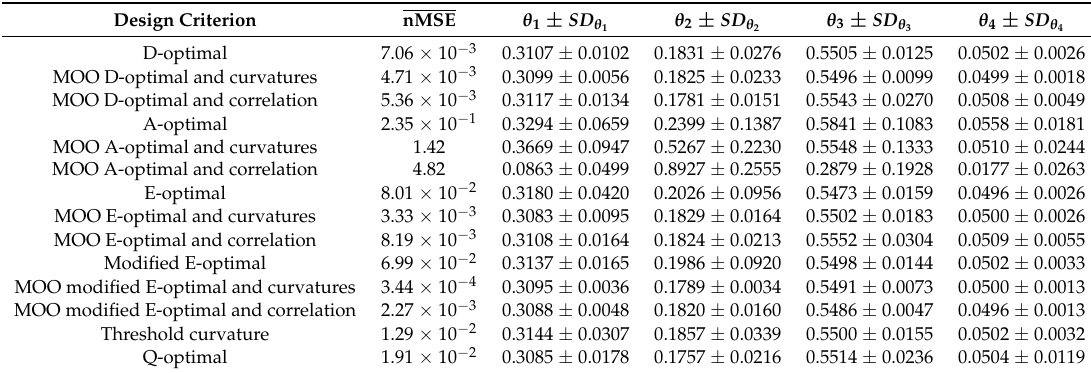
Table 3. Model-based design of experiment (MBDOE) performance on the fed-batch fermentation of baker’s yeast model. The overall parameter accuracy is represented by the average of the normalized mean-square error (nMSE). The reported parameter values and errors are the averages and standard deviations from 100 repeated runs of parameter